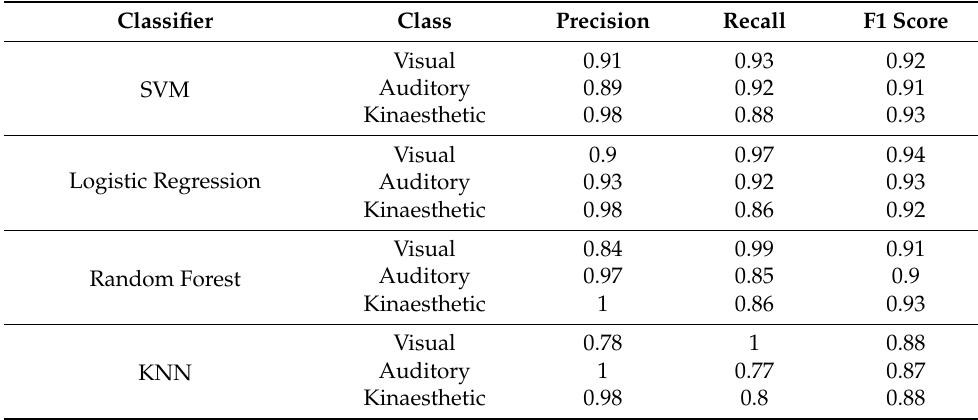
Table 6. Precision, Recall, and F1 score for each class and model.